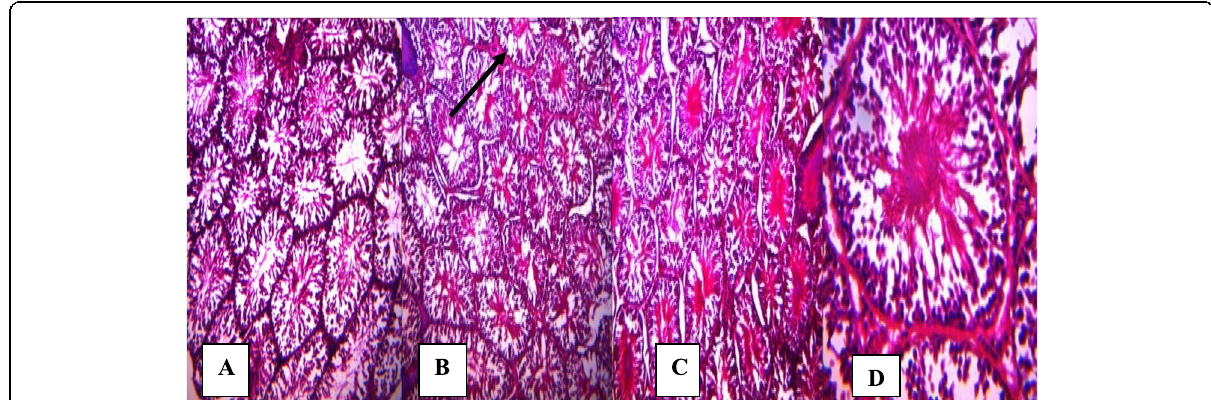
Fig. 10 Figures A-D: Photomicrographs showing effect of chronic variable stress exposure with vitamin C supplementation on histopathology of the testis (H & E stain) A: Control(X200): no visible lesions, B: vitamin C treated (X200): no visible lesions but mild congestion of the interstitium, C: chronic variable stress (X200): no visible lesions, D: chronic variable stress+Vit C (X400): no visible